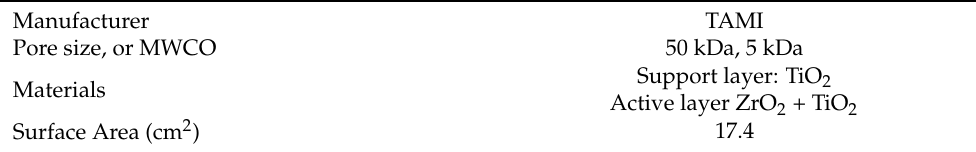
Table 1. Water quality of synthetic seawater used in this